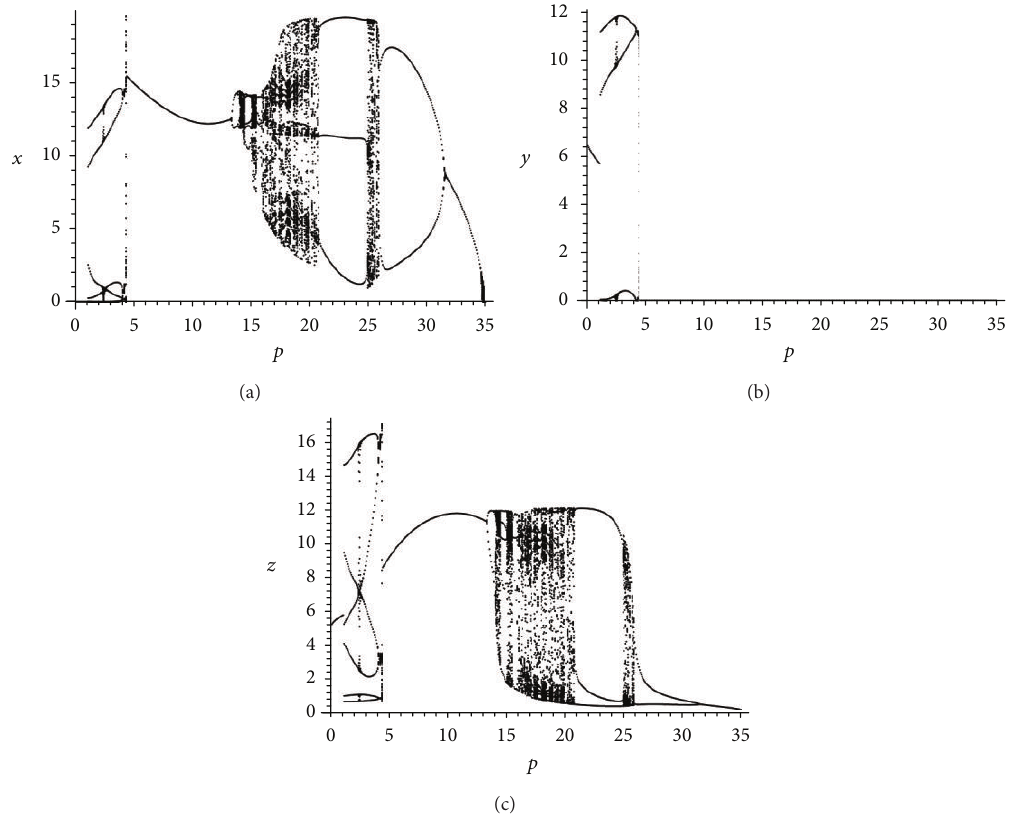
Figure 3: Bifurcation diagram of the system (1) with 0 < 𝑝 ≤ 35